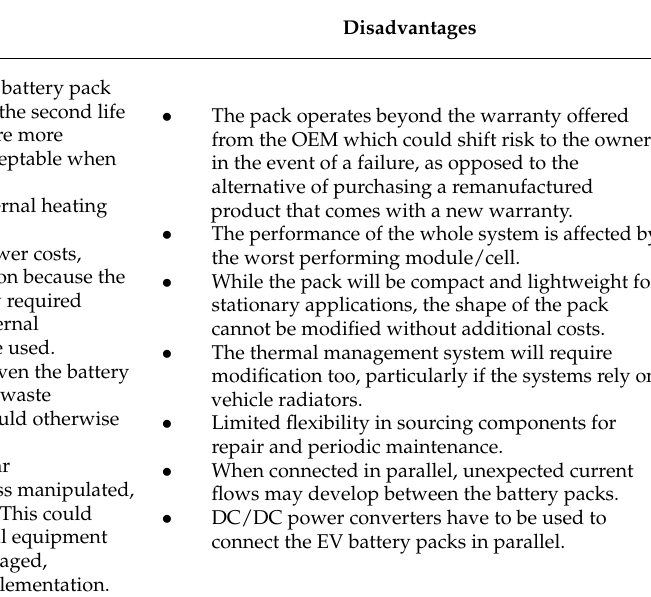
Table 1. Summary of main advantages and drawbacks of the second life application